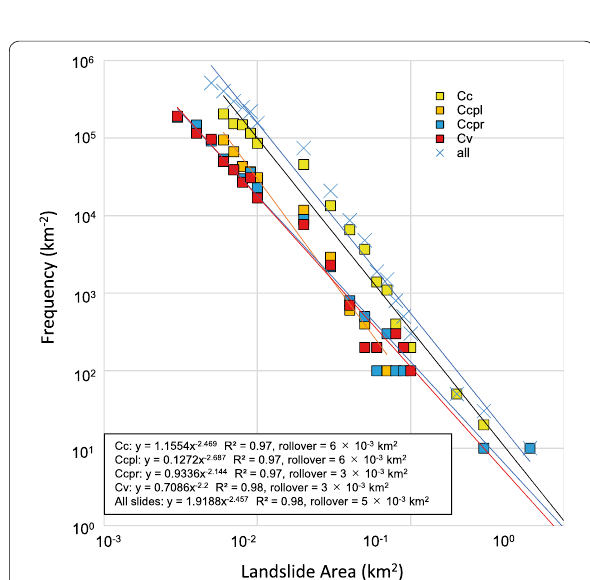
Fig. 16 Frequency-size distribution of landslides for all landslides and each slope type after